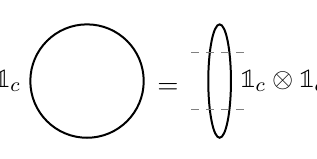
Figure 17. A 1 c -loop is equal to the composition of two 0d domain walls along a 1 c ⊗ 1 c -string.